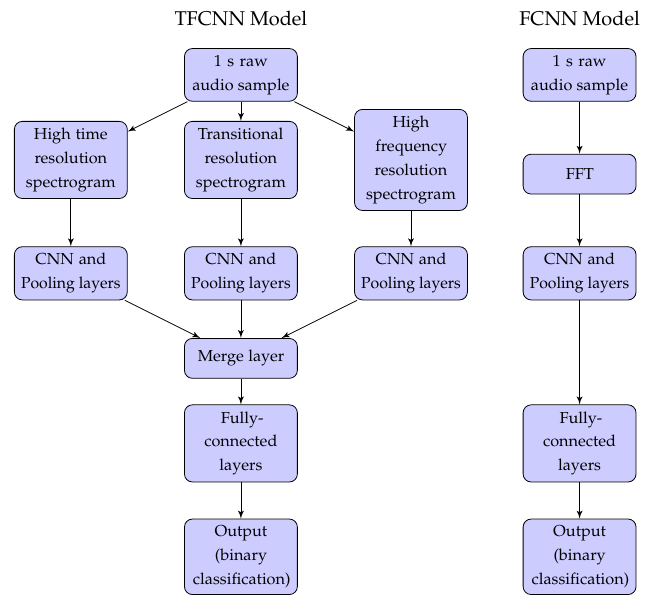
Figure 8. TFCNN and FCNN model structures.